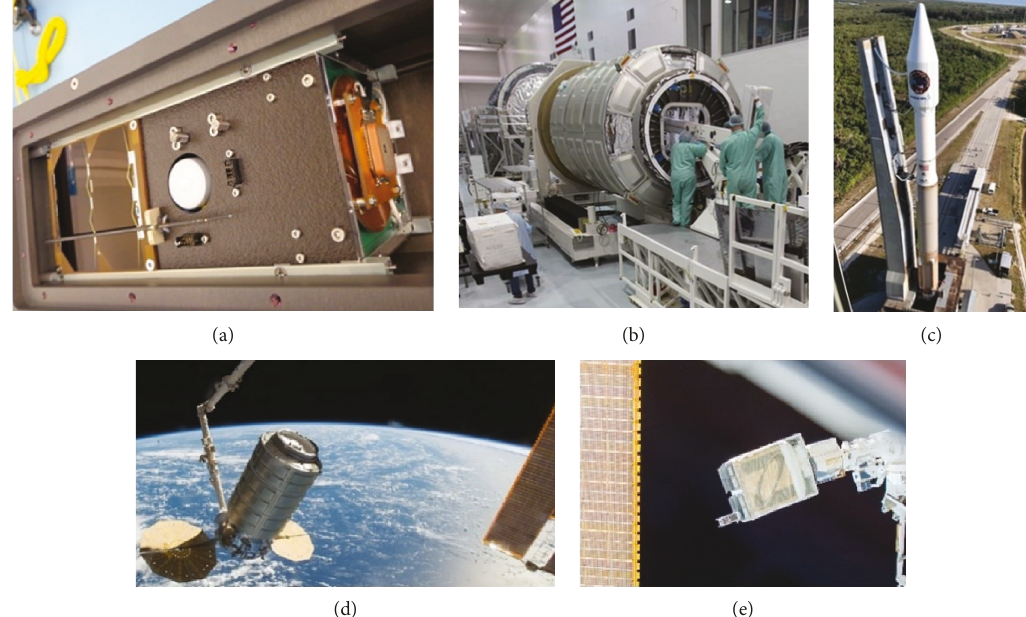
Figure 19: (a) UPSat inside the NanoRacks deployers, (b) integration into the Cygnus cargo, (c) ready for launch, (d) cargo berthed on ISS, and (e) UPSat deployment from